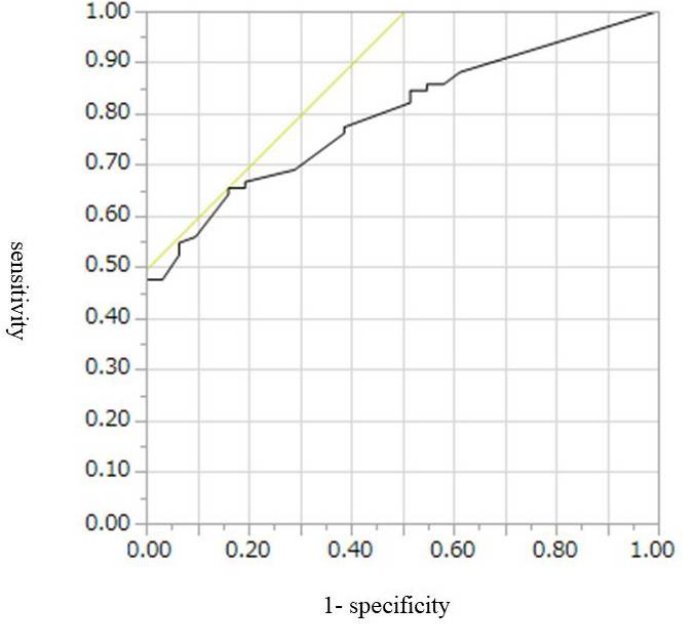
Figure 7. Receiver operating characteristics curve of the presence of mural lesions on CH-EUS for the diagnosis of invasive IPMC. CH-EUS, contrast-enhanced harmonic endoscopic ultrasonography; IPMC, intraductal papillary mucinous neoplasm-associated invasive carcinoma.